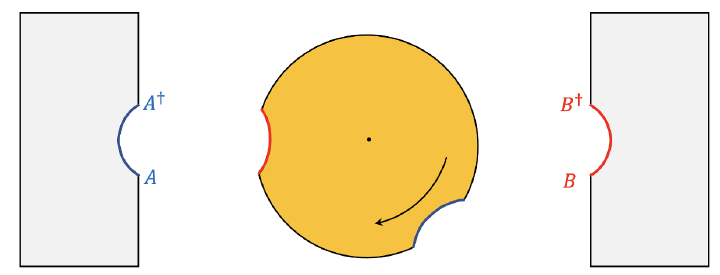
Figure 8 . In the shell approximation the solution has a zero mode which corresponds to a relative rotation between the two shells.